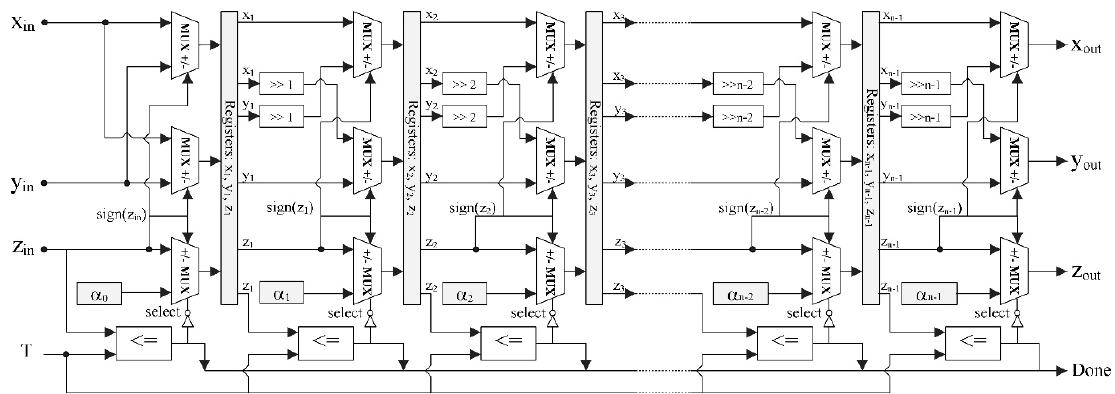
Figure 4. Evaluating the change of rotation angle by the number of iterations.